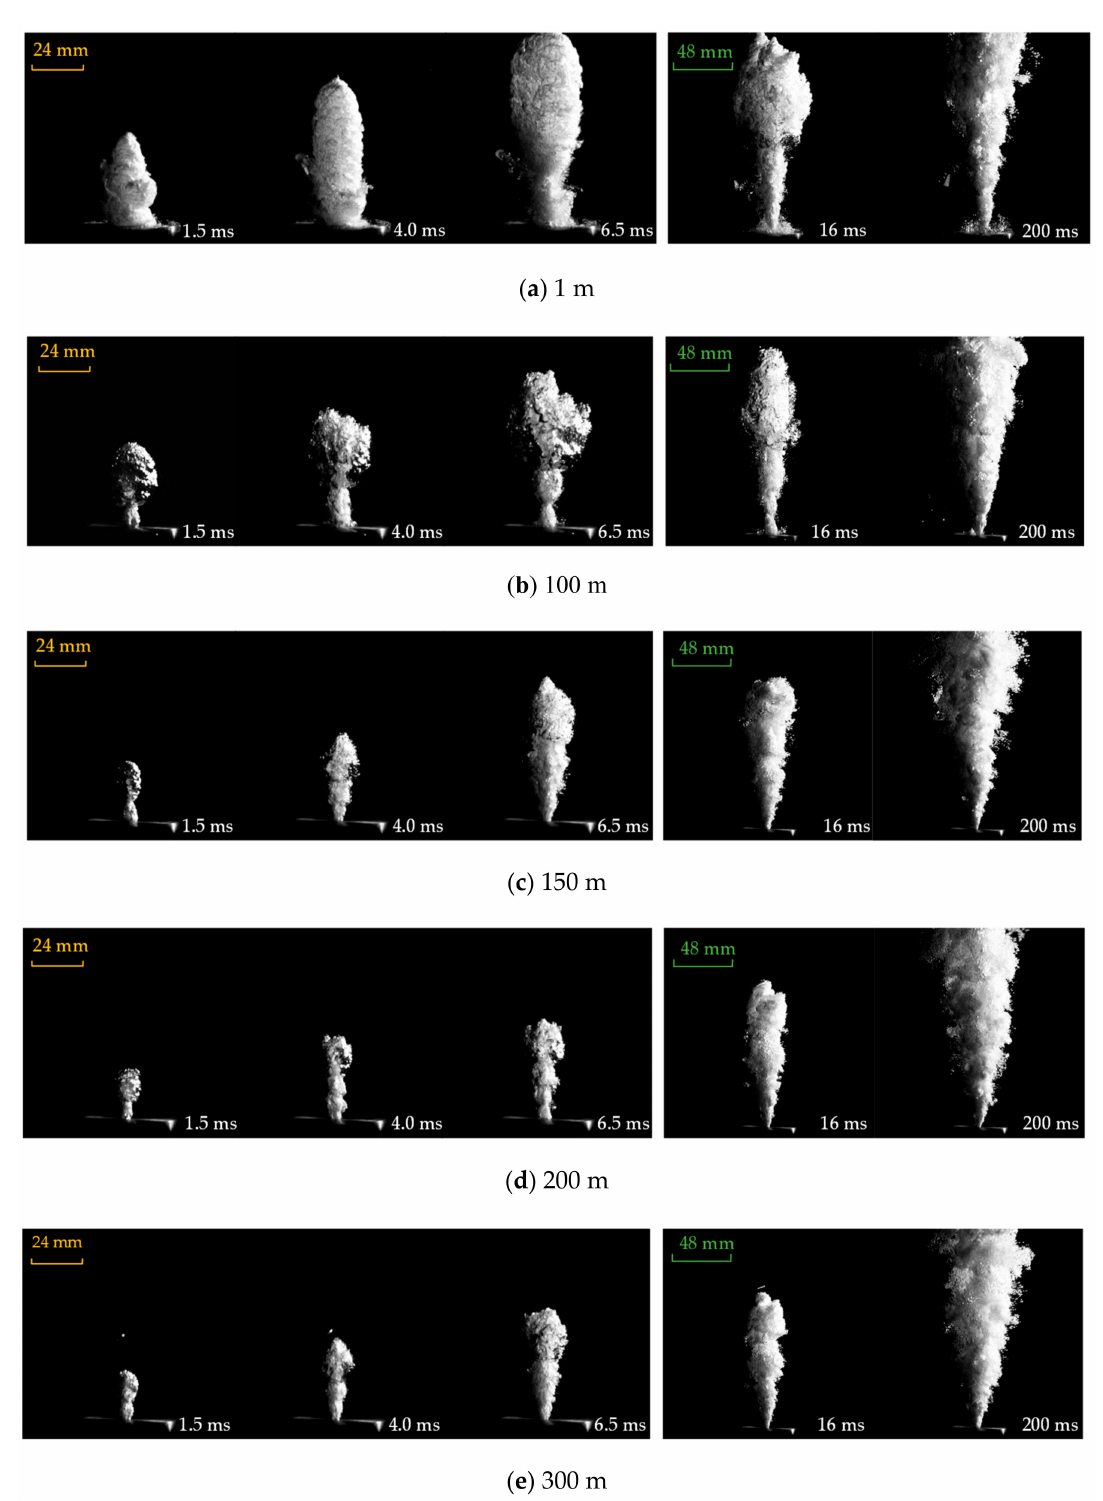
Figure 7. Flow structures at di ff erent water depths (expansion ratio of 1.5625): ( a ) 1 m, ( b ) 100 m, ( c ) 150 m, ( d ) 200 m, and ( e ) 300